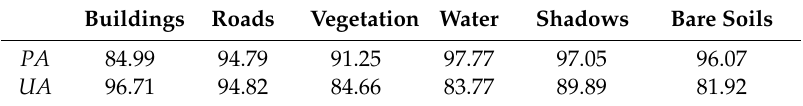
Table 1. Producer accuracy ( PA ) and user accuracy ( UA ) of each class of Beijing dataset (%).